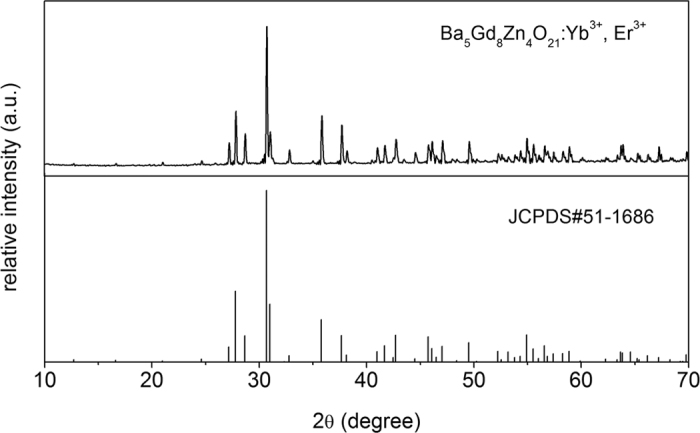
The X-ray powder diffraction.The XRD pattern of the as-synthesized Ba5Gd8Zn4O21:Yb3+, Er3+.